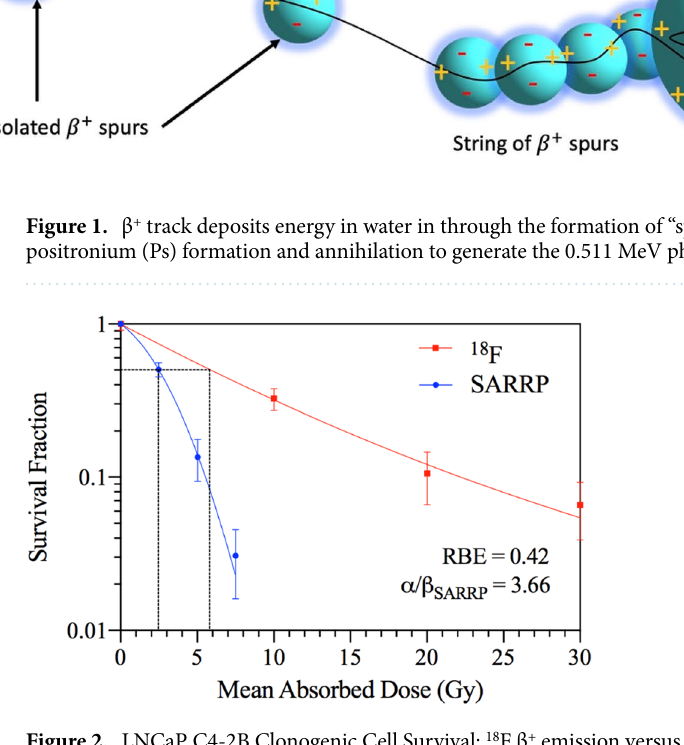
Figure 2. LNCaP C4-2B Clonogenic Cell Survival: 18 F β + emission versus SARRP EBRT. Black dotted line depicts the mean absorbed dose required to reduce cell survival fraction to